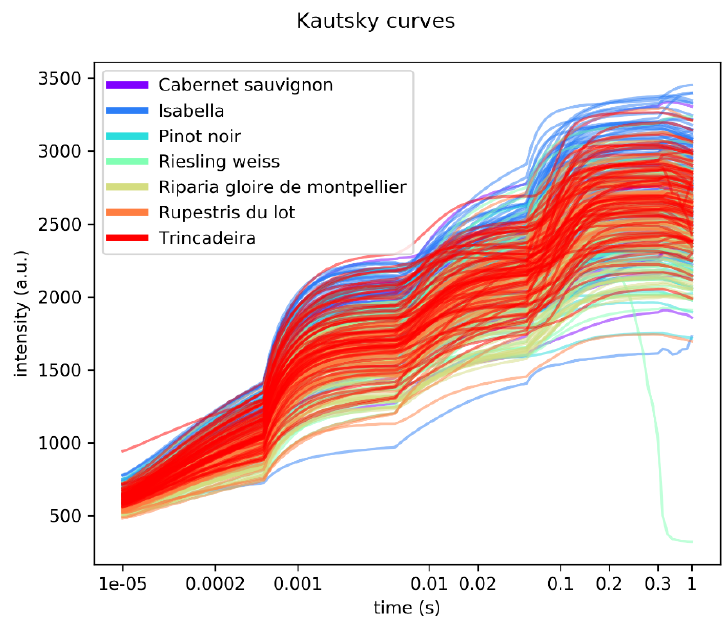
Figure 2. Overlap of all rapid fluorescence induction curves measured.